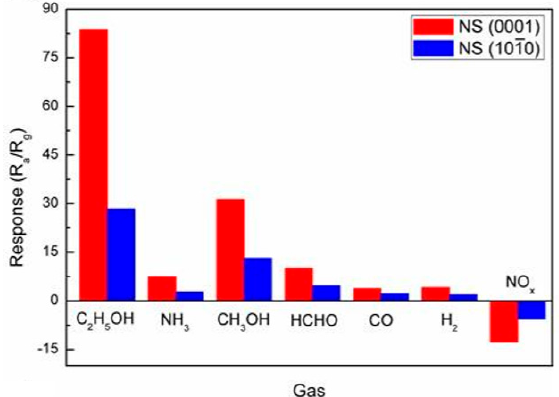
Figure 39. Response of ZnO nanosheets-based sensors to di ff erent gases. ZnO nanosheets in these sensors are faceted by di ff erent crystallographic planes, (0001) and ± (0110), respectively. Reproduced with permission from Xu et al. [200]. Copyright 2017: Elsevier.